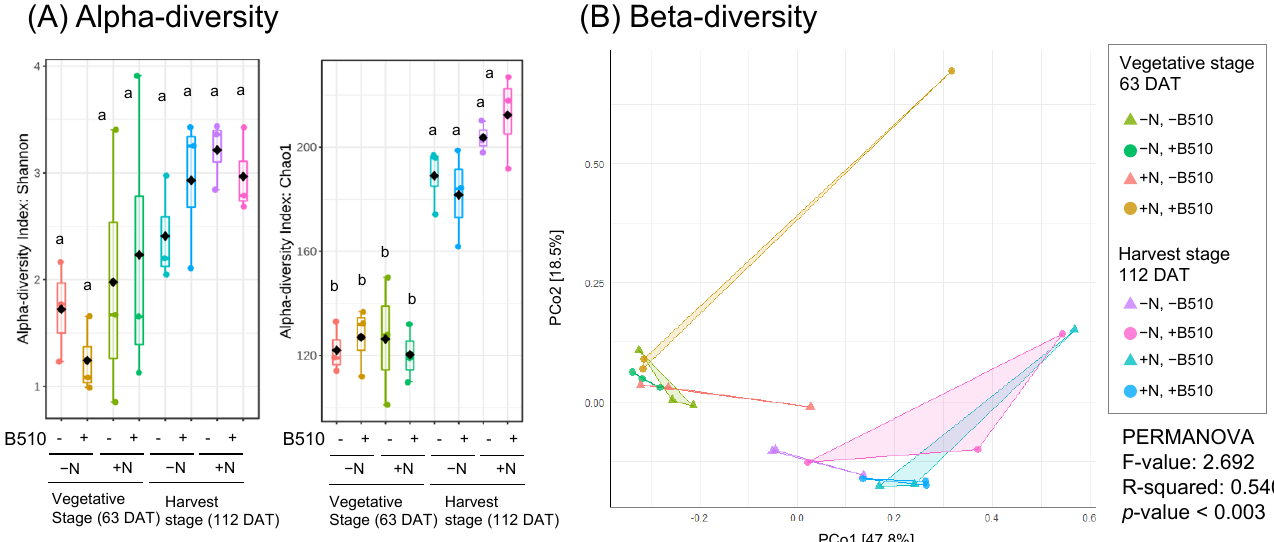
Figure 5. Influence of B510 on root-colonized microbiota with different levels of N-fertilization and two stages of plant development. Measurement of the alpha-diversity ( A ) and beta-diversity ( B ) of the rice root-colonized fungi. Rice plants inoculated with B510 (+) and without B510 ( − ), and fertilized with chemical nitrogen (+N) and non-fertilized ( − N) harvested at the vegetative stage (63 DAT) and the harvest stage (112 DAT). ( A ) Shannon index and Chao1 index were used in the analysis of the alpha diversity. All values are means of three replicates ± standard errors. Statistical analysis was performed, different letters indicate significant difference between treatments (Student- Newman-Keuls [SNK] test, p < 0.05, n = 3). ( B ) Principal Coordinate Analysis (PCoA) are plotted based on Bray-Curtis distance metrices for taxonomical data ( p < 0.01). Permutational multivariate analysis of variance (PERMANOVA) was